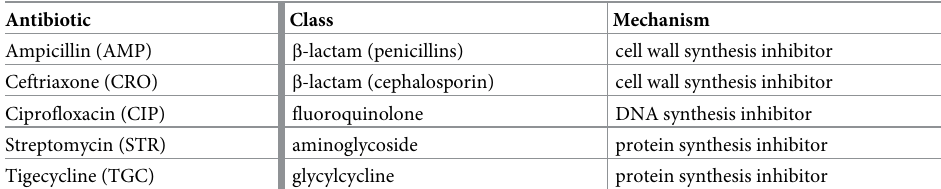
Table 1. Antibiotics used in this